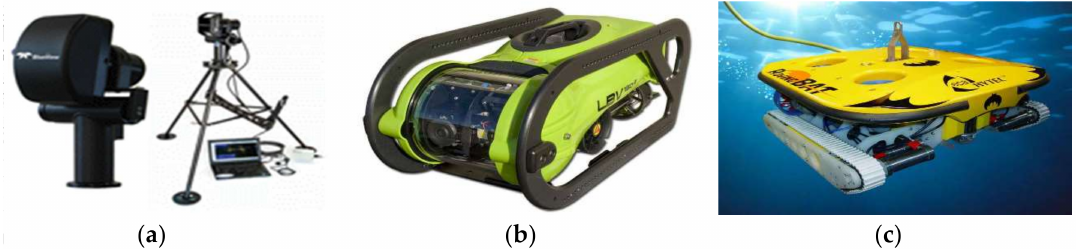
Figure 1. Trend of underwater survey equipment. ( a ) BV5000; ( b ) Seabotix’ ROV; ( c ) Roving